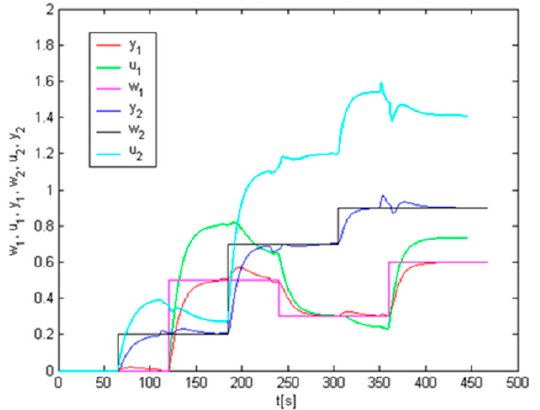
Figure 7. Output of control .